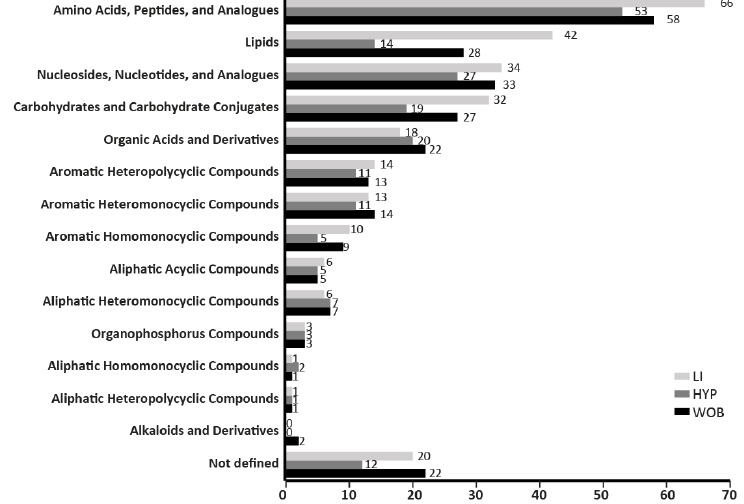
Figure 2. The number of metabolites categorized per chemical classes in the initial set of metabolites analyzed did not differ between the three tissues (liver LI, hypothalamus HYP and whole olfactory bulb WOB).